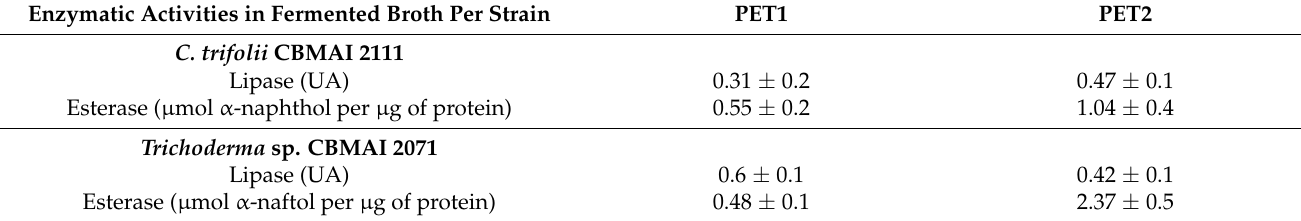
Table 8. Lipase and esterase activities in the fermented broth.